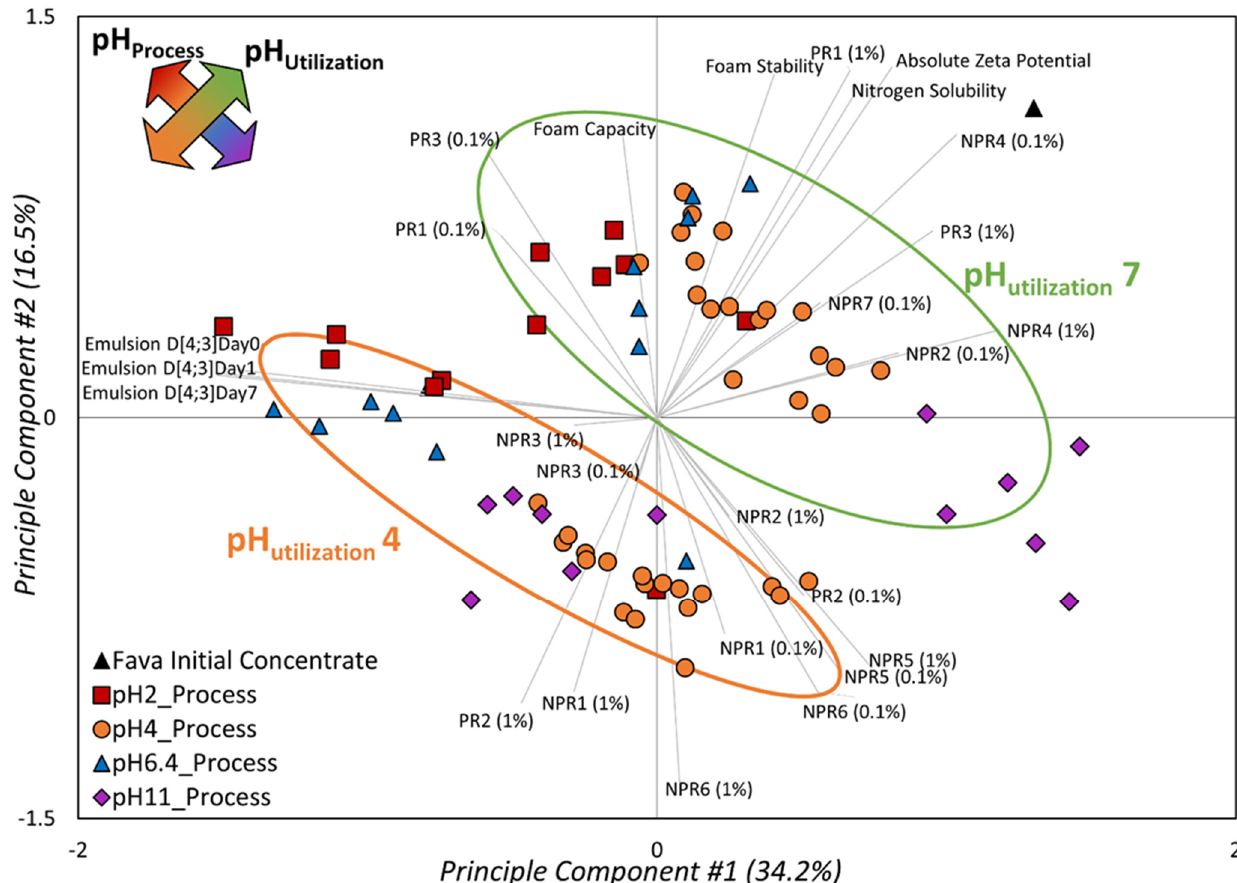
Figure 2. Principal Component Analysis: PCA biplot of fava ingredients (1 fava bean initial concentrate + 36 modified concentrates) evaluated at two conditions (pH 4 and pH 7) as scores, with the foam and emulsion functionalities and other ingredient attributes as loadings. The effect of pH during modification is shown by different symbols. The pH during utilization process is indicated with confidence ellipses ( α = 0.95). PR and NPR are the PARAFAC components (at 0.1% and 1%, Table 1) based on the protein and non-protein regions of the fluorescence landscape.